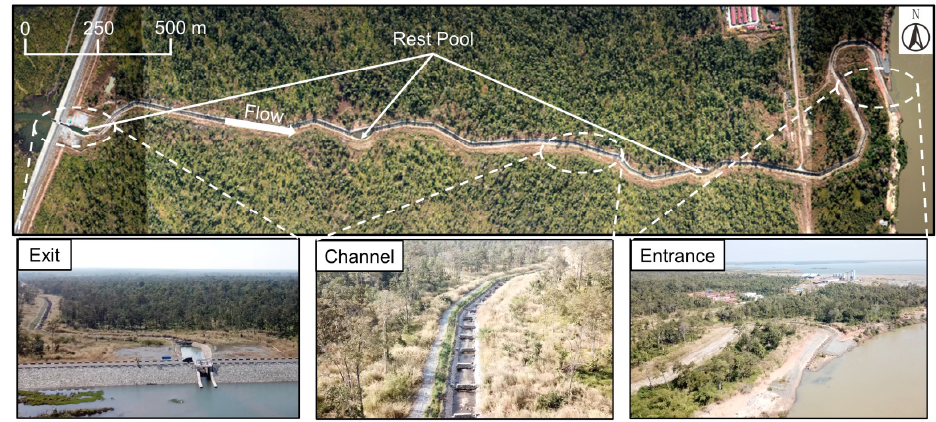
Figure 2. Aerial photographic representation of the nature-like bypass in the Sesan River.